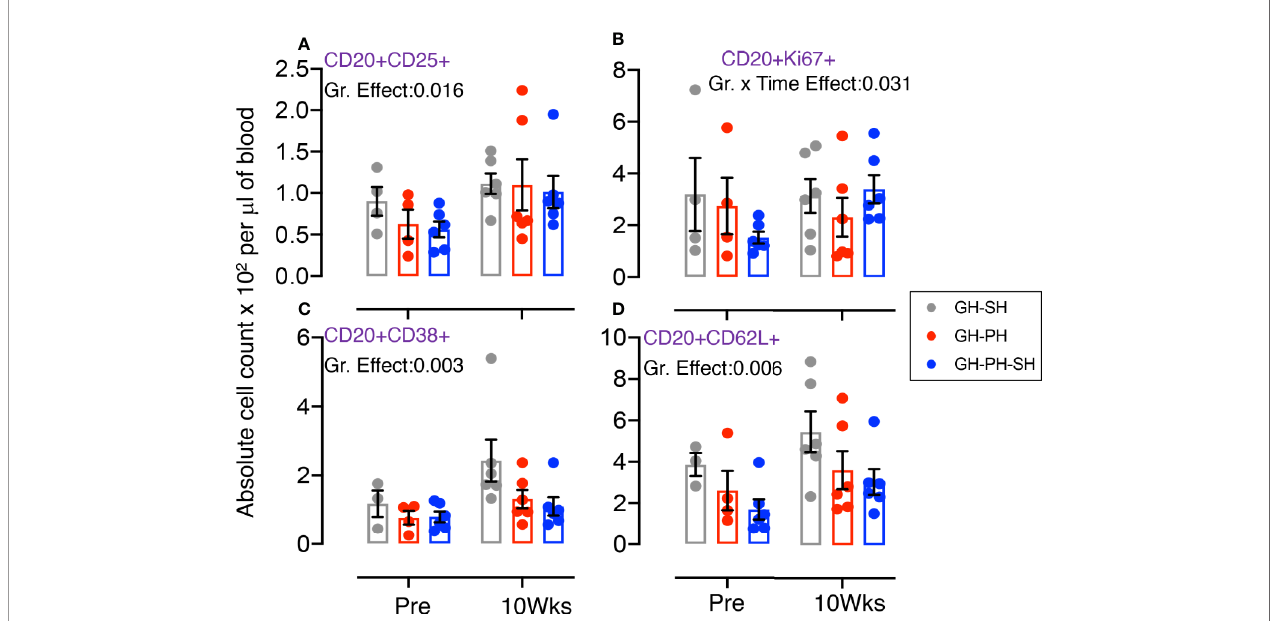
FIGURE 5 | Absolute count of peripheral blood CD20+ B cells and its subpopulation were shown for GH-SH, GH-PH, and GH-PH-SH groups. A signi fi cant difference in regulatory CD20+CD25+ (A) , proliferating CD20+Ki67+ (B) , activating CD20+CD38+ (C) , and traf fi cking CD20+CD62L+ (D) cells was detected among groups across housing treatment time points. Interestingly, a signi fi cant interaction effect between time and group in proliferation CD8+Ki67+ B cells was detected (p = 0.031). The X axis denotes pre- and post-separation housing time points and the Y axis denotes absolute counts. Individual values from each animal are shown as colored circles with bars showing mean ± standard error for each